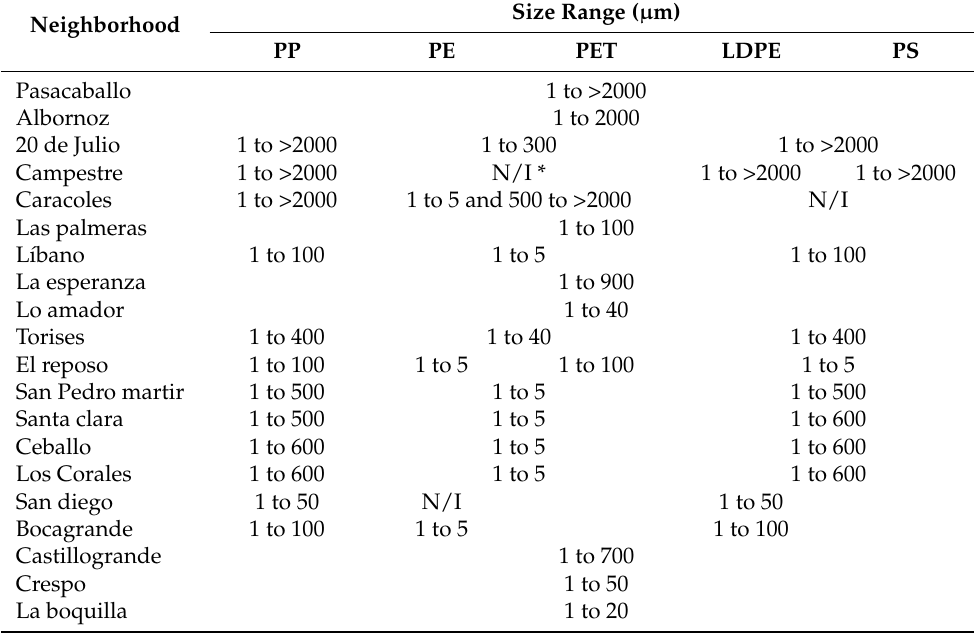
Table 2. Identification of the MPs in the different neighborhoods.